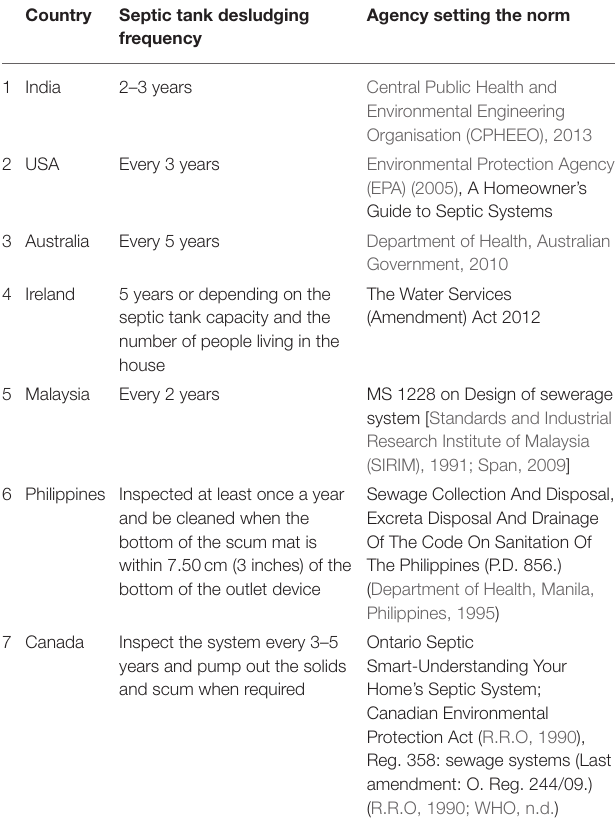
TABLE 1 | Standards for frequency of septic tank desludging.